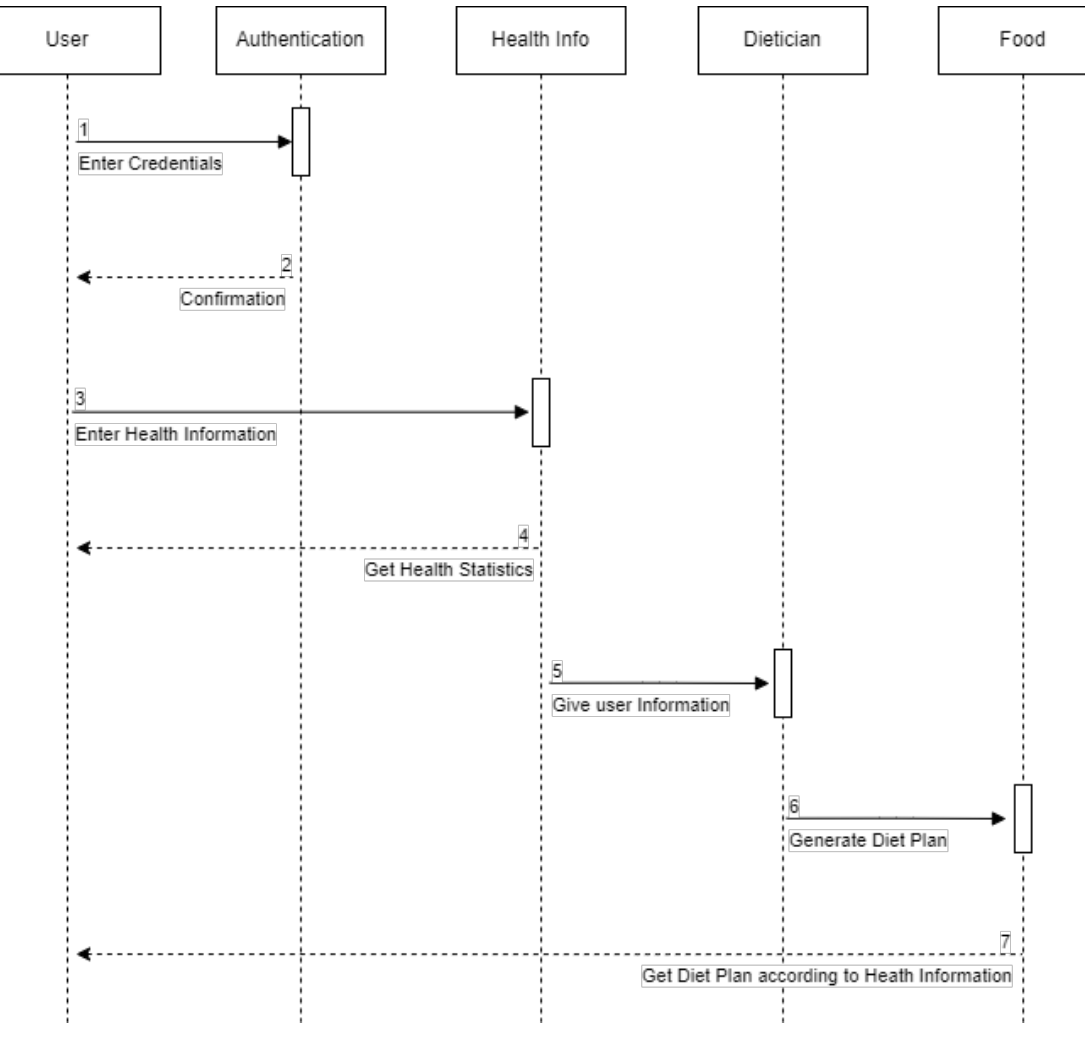
Figure 17. Sequence Diagram of proposed